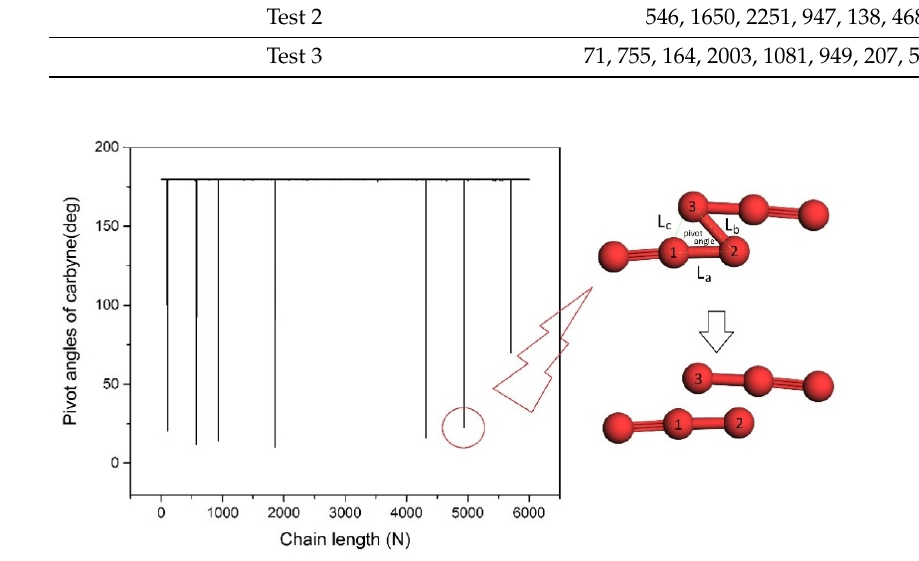
Figure 5. The chain stability factor is a measure of atomic fluctuations of LCC@(6,4)CNT. The reduction in the chain stability factor is more pronounced at N > 6000. The inset shows that our sample reached an equilibrium state at the Monte Carlo steps exceeding ~180,000. A compressive strain in the radial direction to the LCC@(6,4)CNT deteriorates the Table 2. The probable sizes of carbyne fragments in the ~4% compressed (6,4)CNT at 300 K. chain stability. The chain stability factor drops from 0.69 to 0.68 at a compressive strain of 2%. However, when the compressive strain reaches 4% in test 1 (Table 2), the formation of seven extremely sharp pivot angles within ~10 o < pivot angle < ~60° at n = 103rd, 576th, 932nd, 1853rd, 4318th, 4943rd, and 5705th atom are observed in Figure 6. The critical kink